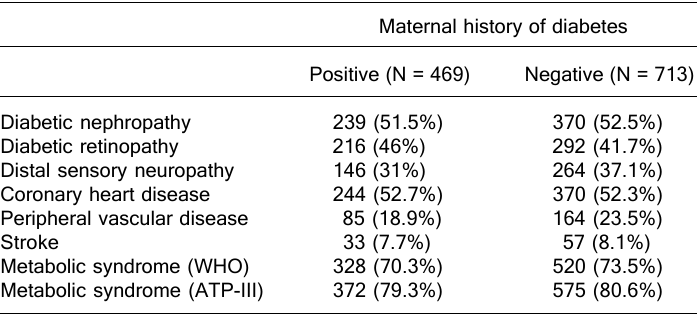
Table 2. Frequency of chronic diabetic complications and metabolic syndrome in patients with or without maternal diabetes